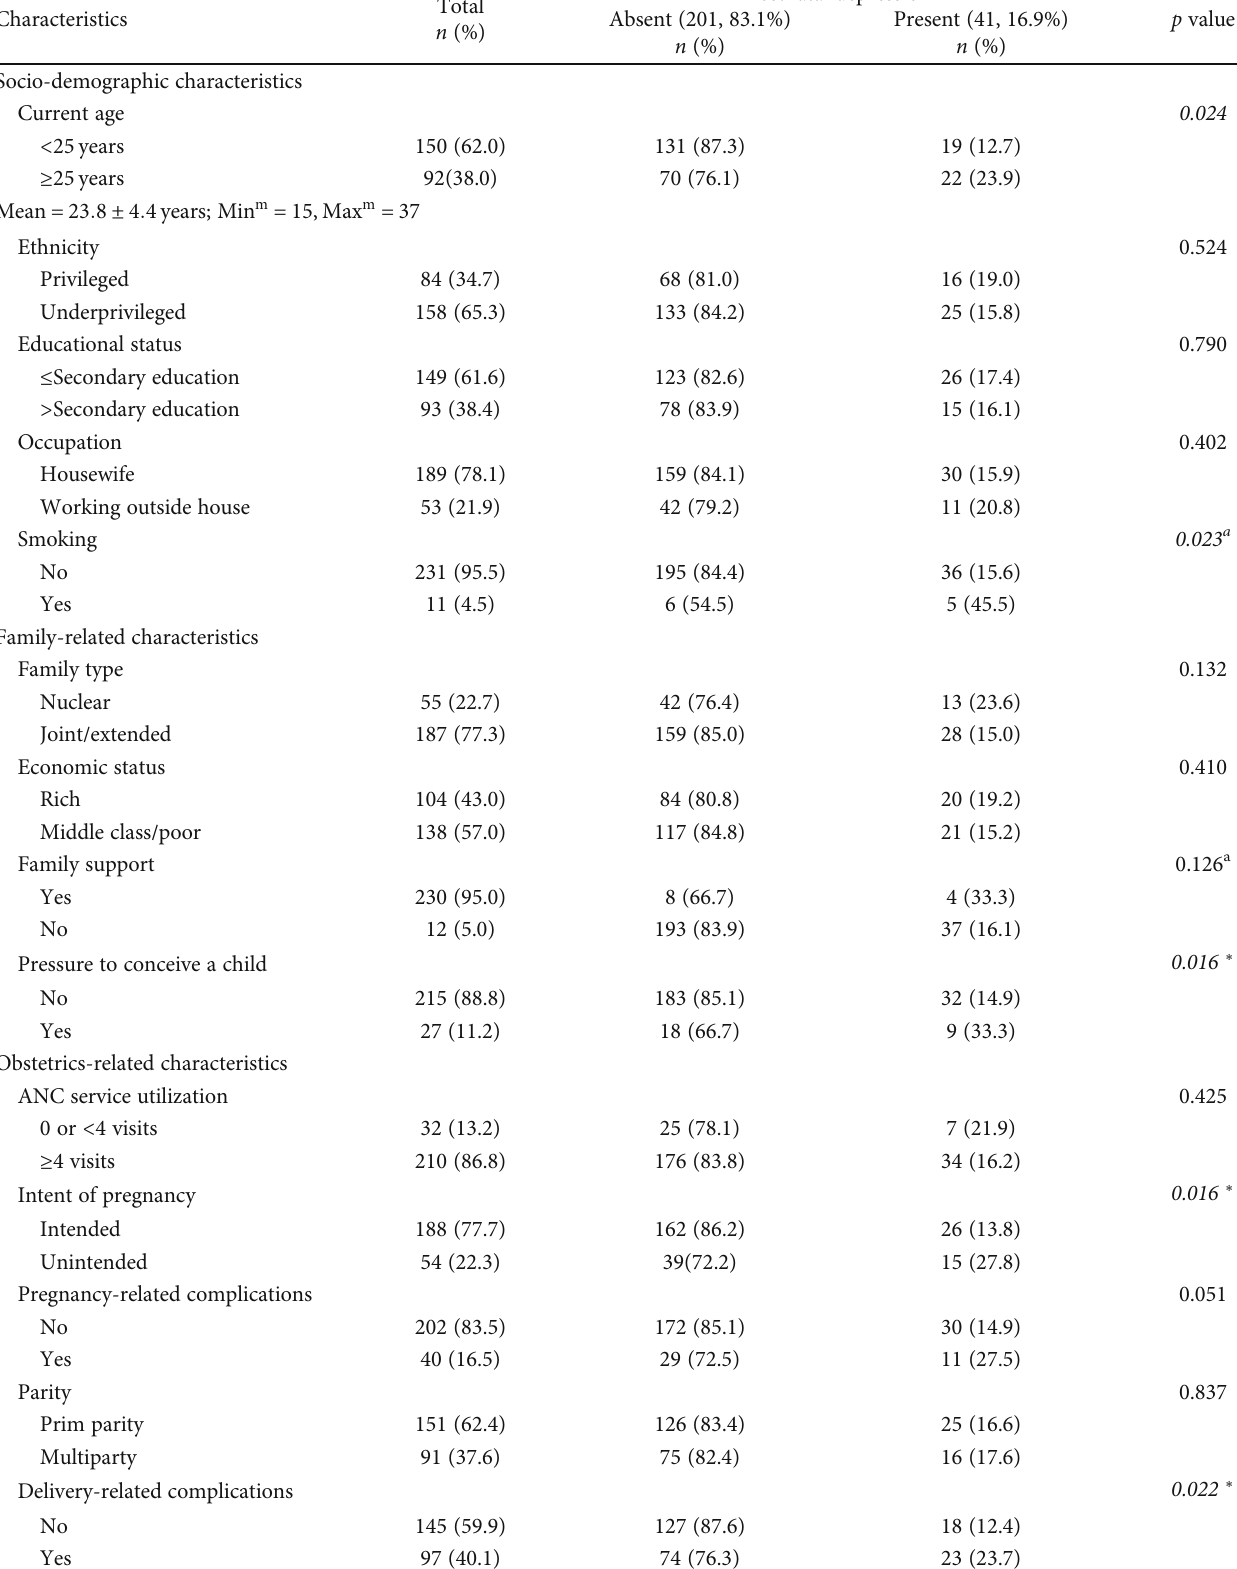
Table 1: Association between sociodemographic, family-related and obstetrics-related characteristics, and postnatal depression ( n = 242 ).